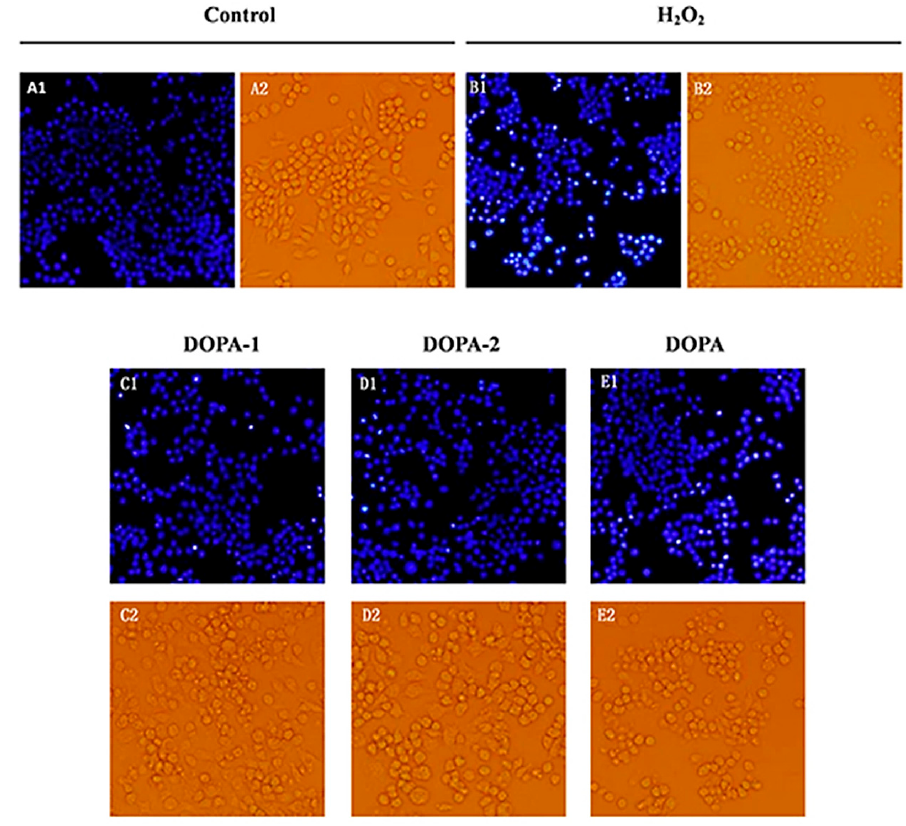
Figure 7. Effects of D. officinale polysaccharides on cell morphology of RAW 264.7 cells treated with H 2 O 2 . (1) Morphological changes of RAW 264.7 cells were observed by fluorescence microscope after staining with Hoechst 33258. (2) Morphological changes of RAW 264.7 cells were observed by phase-contrasted microscopy. ( A1 / A2 ) Cells treated with medium alone; ( B1 / B2 ) cells treated with H 2 O 2 alone; ( C1 / C2 ) cells pretreated with DOPA-1 (100 μ g/mL) prior to exposure to H 2 O 2 ; ( D1 / D2 ) cells pretreated with DOPA-2 (100 μ g/mL) prior to exposure to H 2 O 2 ; ( E1 / E2 ) cells pretreated with DOPA (100 μ g/mL) prior to exposure to H 2 O 2 .